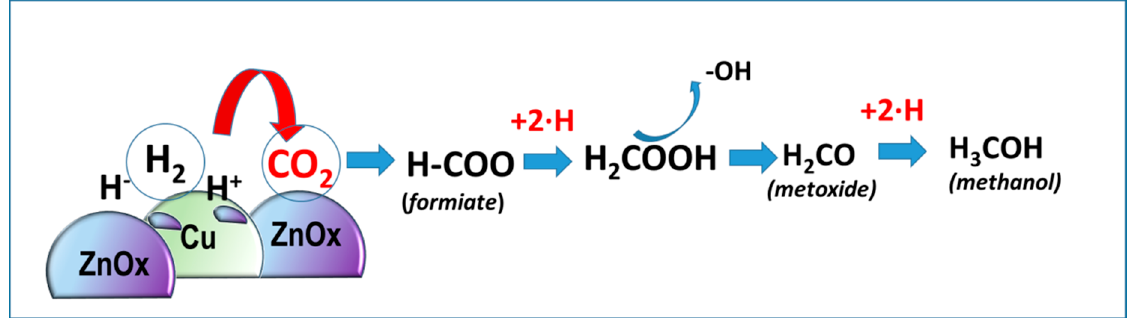
Figure 4. Schematic representation of the elementary steps involved in the hydrogenation of CO 2 to methanol over Cu/ZnO catalysts .